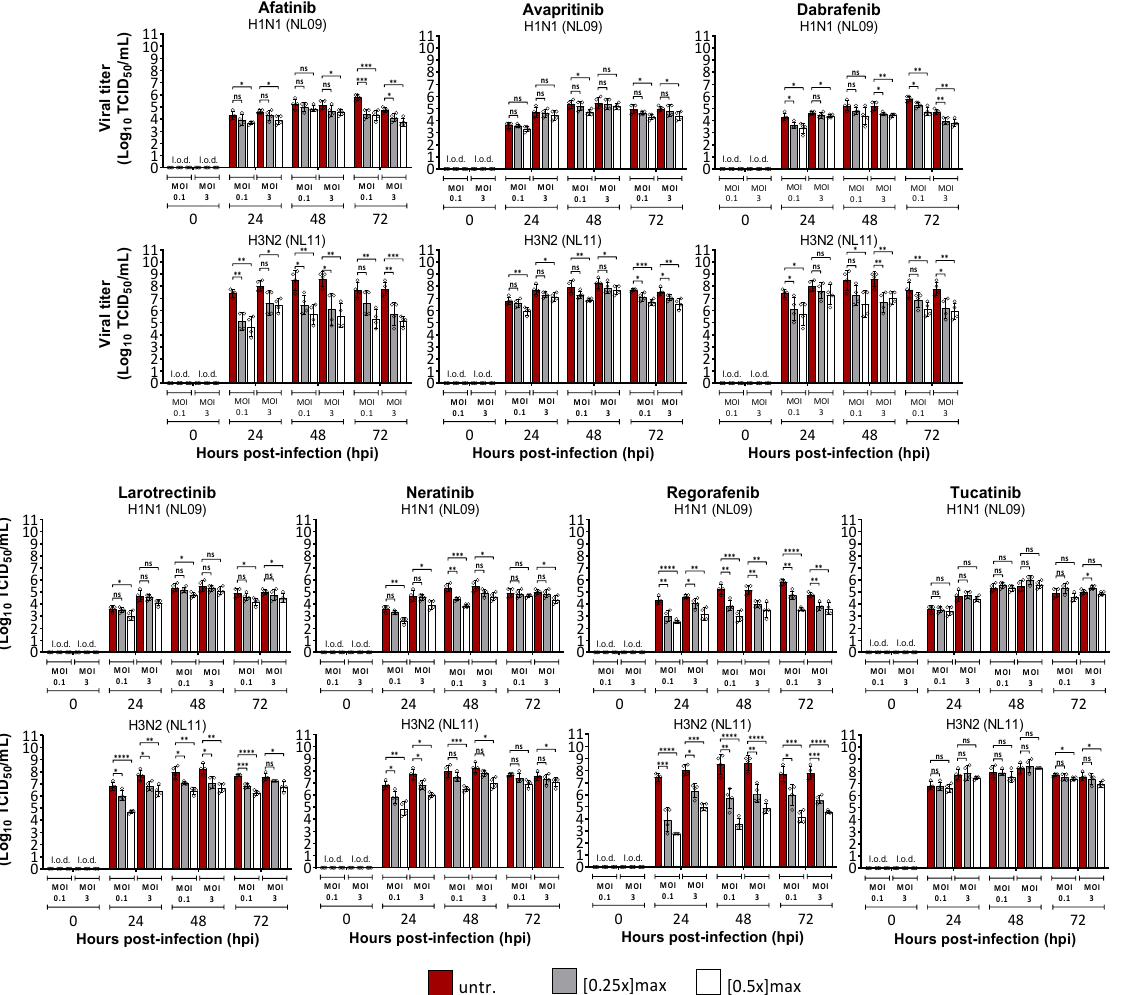
Figure 2. MOI-independent effects of SMKIs on IAV infection in vitro. A549 cells were infected with NL09 and NL11 at MOI = 0.1 (low) or MOI = 3 (high) for up to 72 hpi in the presence of SMKIs at [0.25×] max (gray) and [0.5×] max (white) concentrations or left untreated (red). At 24, 48 and 72 hpi, supernatants were collected, and viral titers were quantified by a TCID 50 /mL assay ( n = 4). Means ± SDs are shown. l.o.d.: limit of detection. *, p < 0.05; **, p < 0.01; ***, p < 0.001; ****, p < 0.0001; ns, not significant. p ‐ values were determined by Welch t ‐ tests.